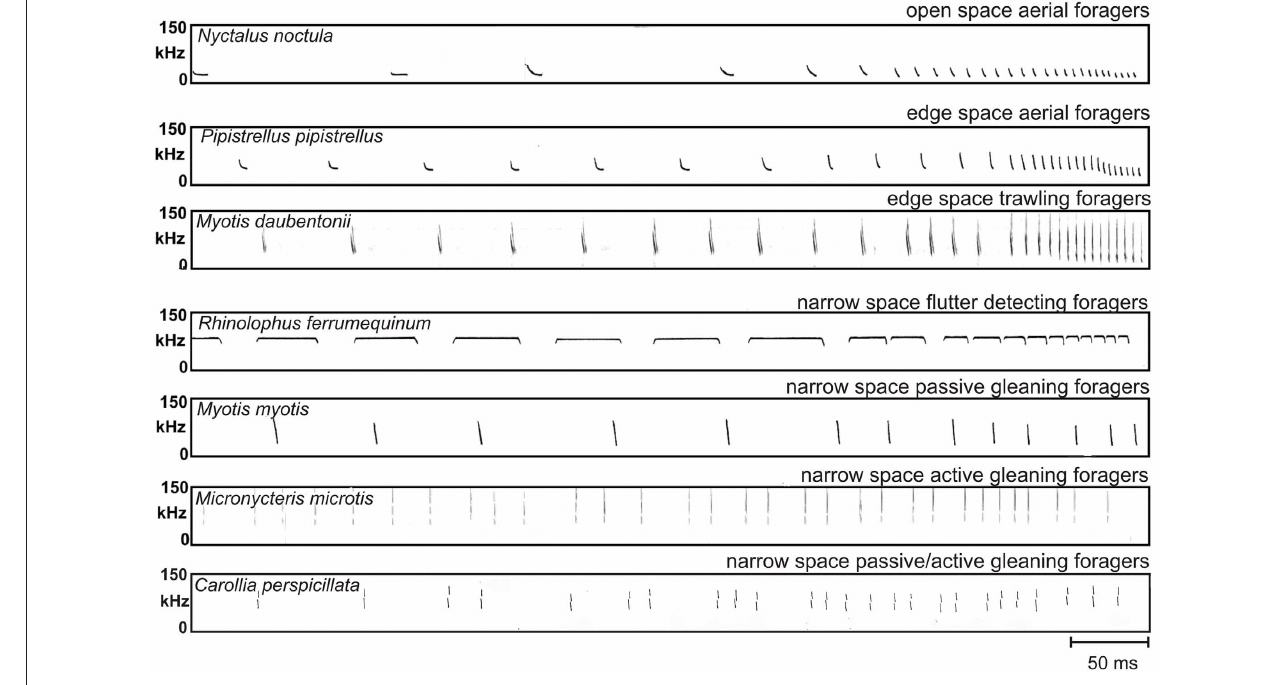
grouping is less distinct and pulse intervals are larger than in active and passive/active gleaning foragers. Echolocation is exclusively used for landing control. The approach signals of narrow space active and passive/active gleaning foragers are clearly arranged in groups of two to five. Repetition rate is higher than in passive gleaning foragers. Echolocation is used to approach a stationary identified food item and to evaluate the orientation of the prey in order to grab